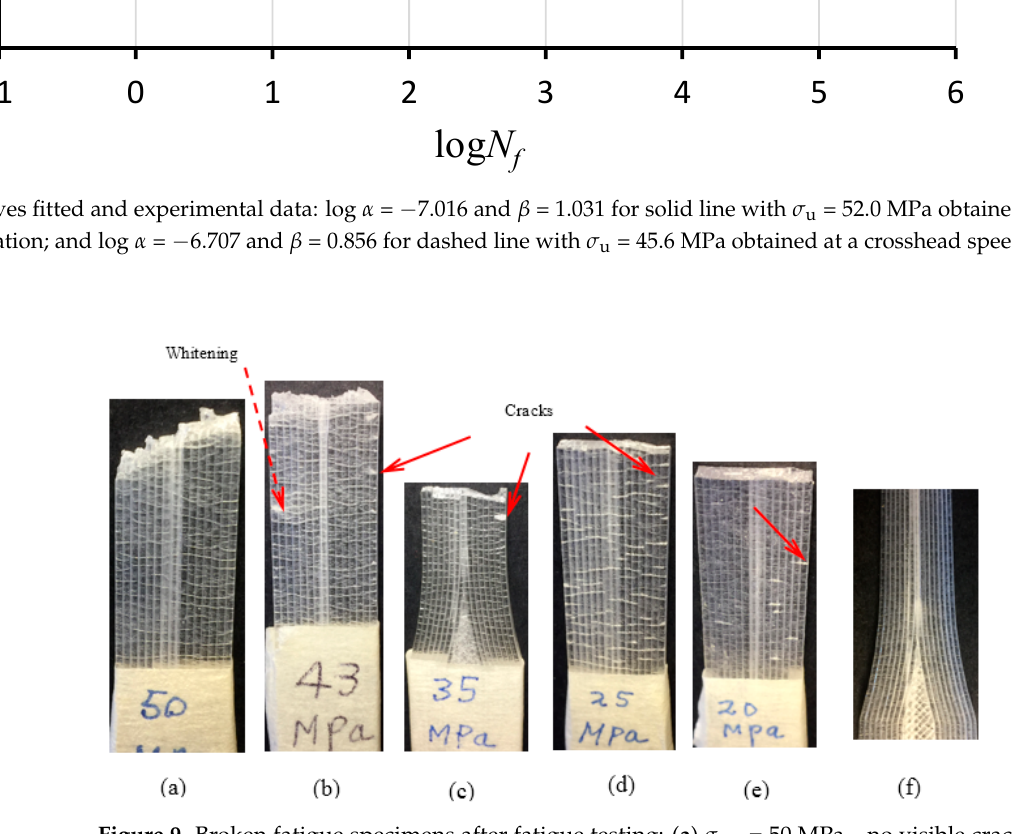
Figure 9. Broken fatigue specimens after fatigue testing: ( a ) σ max = 50 MPa—no visible cracks outside fracture surface; ( b ) σ max = 43 MPa—multiple small cracks with whitening along the edges; ( c ) σ max = 35 MPa—one crack is clearly visible; ( d ) σ max = 25 MPa—many cracks are seen; ( e ) σ max = 20 MPa—multiple crack are visible; and ( f ) untested.